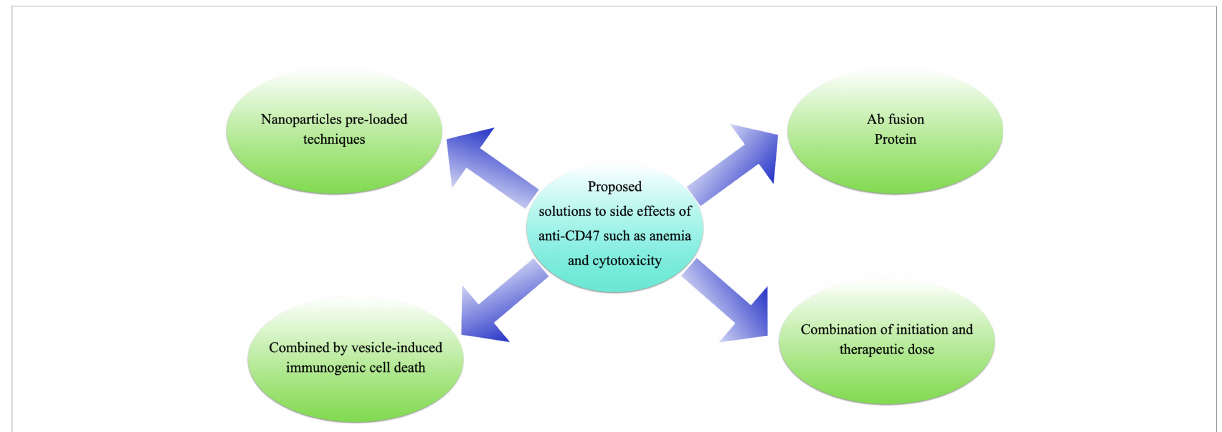
FIGURE 6 Proposed solutions to the side effects of anti-CD47 treatments. (A) antibody fusion proteins, e.g., TTI-621 (116) or ALX-148 (26); (B) “ initiation doses ” followed by “ therapeutic doses ” , e.g., Hu5F9-G4 (117); (C) pro-drug vesicle-induced immunogenic cell death combined with CD47 blockade (54); or (D) tumor-targeting nanoparticles loaded with anti-CD47 antibody